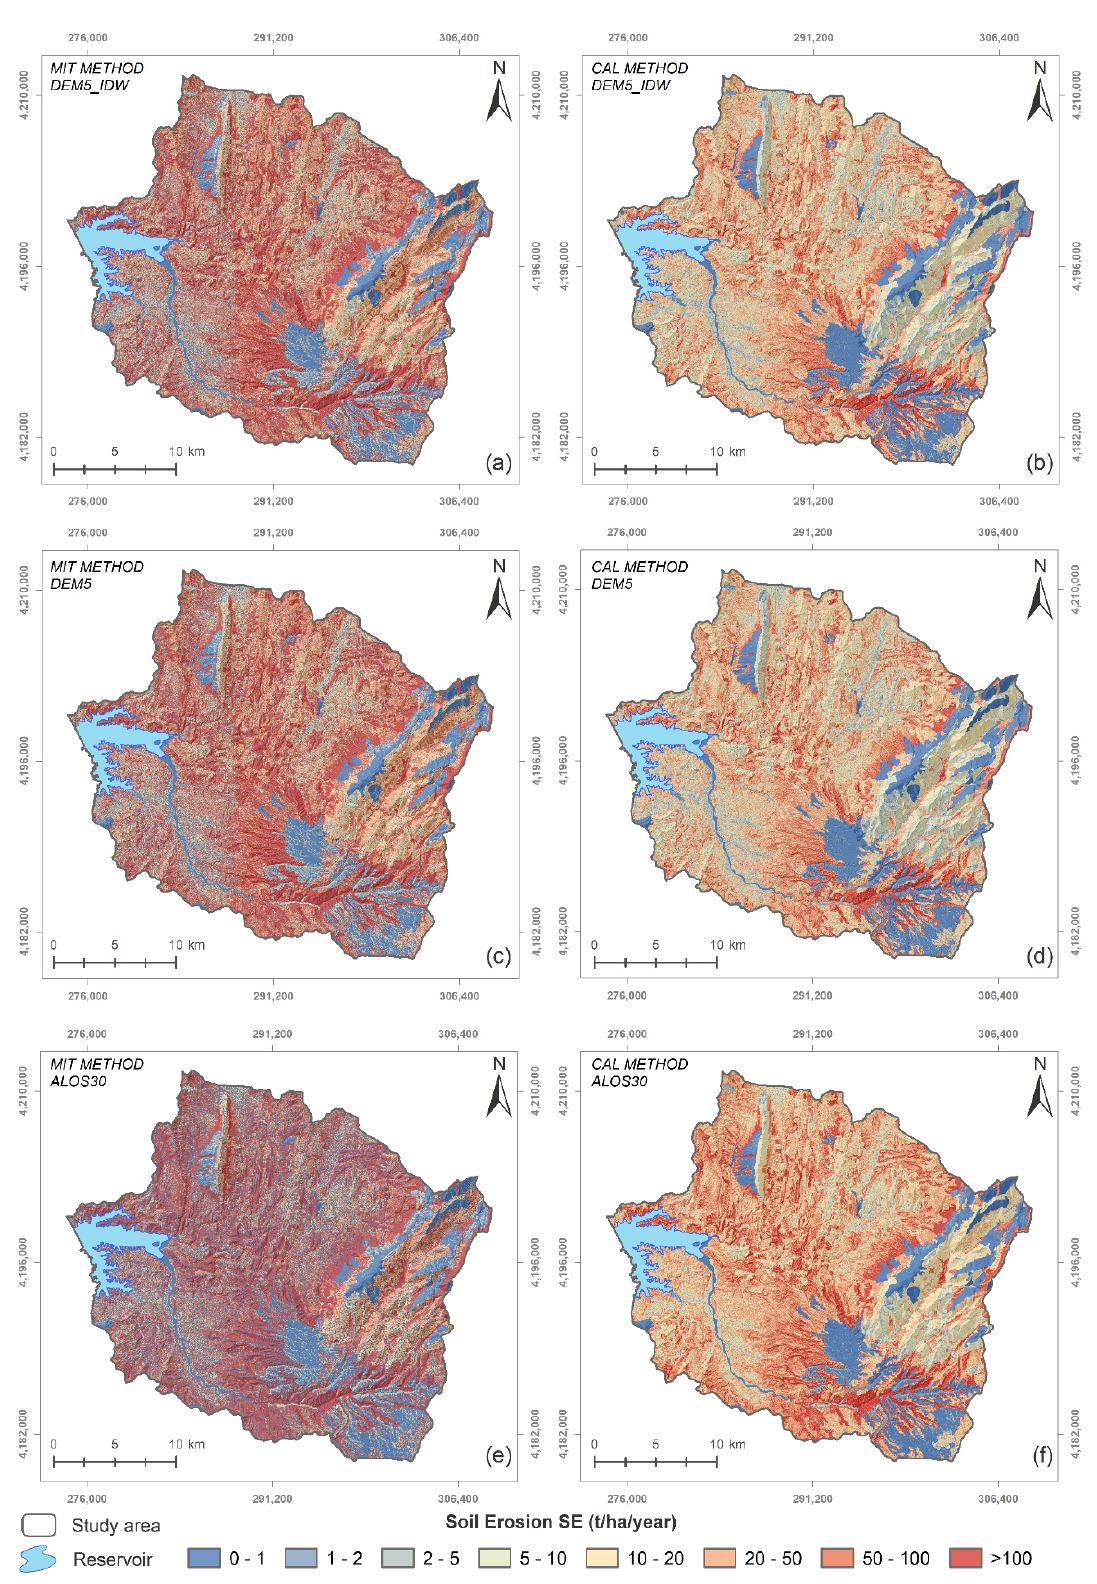
Figure A6. Maps of soil erosion annual rates (SE) calculated with the LS factor computed with the MIT method applied on DEM5_IDW ( a ), DEM5 ( c ), and ALOS30 ( e ) as well as the CAL method applied on DEM5_IDW ( b ), DEM5 ( d ), and ALOS30 ( f ).